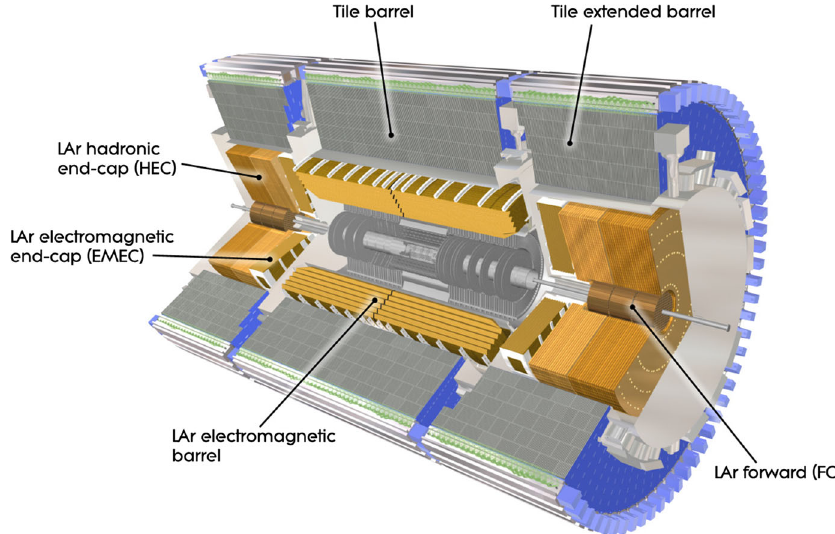
Fig. 1 Cut-away view of the ATLAS calorimeter